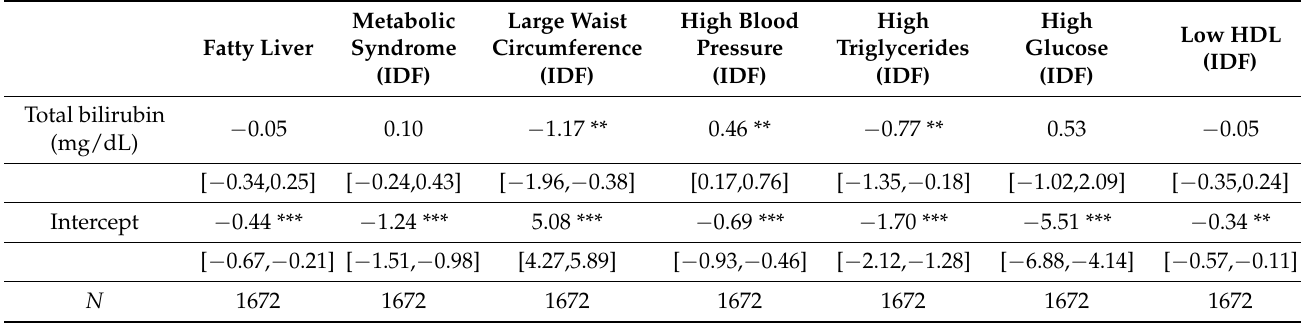
Table 4. Univariable logistic regression models evaluating the association between serum total bilirubin, fatty liver, and the metabolic syndrome and its components.